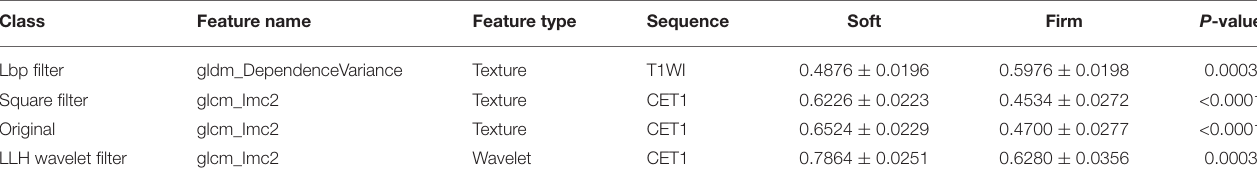
TABLE 3 | The four key radiomic features detail